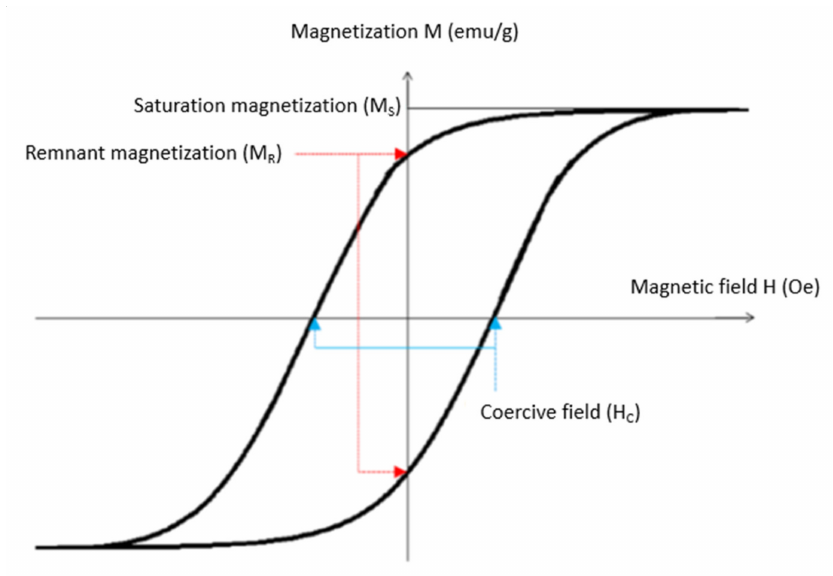
Figure 4. Magnetization cycle depending on the field applied for a massive ferro/ferrimagnetic material. In Figure 4, the magnetization of the material reaches the maximum value M S (or saturation magnetization) when the imposed field increases enough. All spins are oriented in the same direction. The hysteresis curve also makes it possible to highlight the non- instantaneous nature of the orientation of the magnetic spins within a solid material, thus inducing a delay in magnetization. Two characteristic values of the material can be